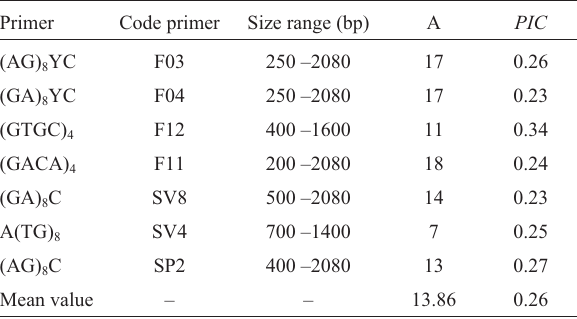
Table 2 - ISSR primers, size range (bp) of the amplified fragments, num- ber of loci ( A ), and polymorphism information content ( PIC ) for Calydorea